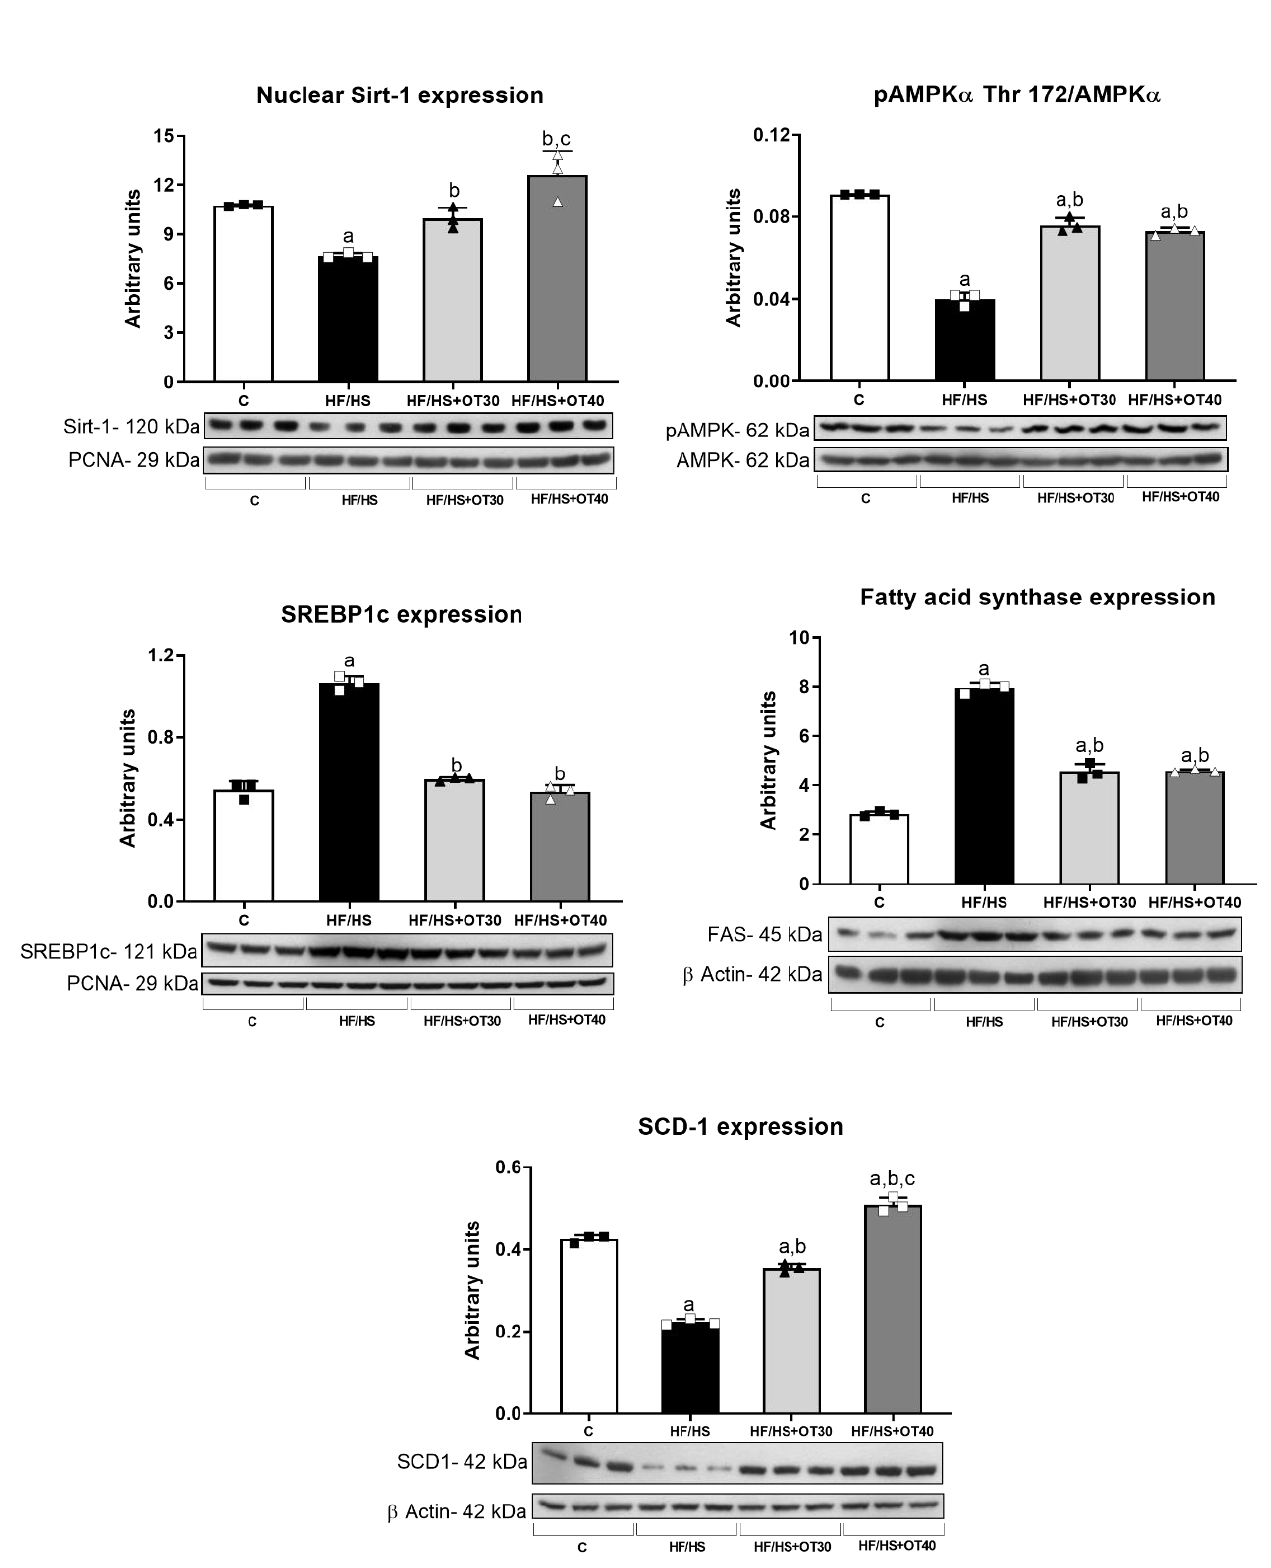
Figure 5. Lipogenesis studies. Renal expression of Sirt-1, stearoyl CoA desaturase 1 (SCD-1), AMPK α , phospho-AMPK α Thr 172, SREBP1c, and fatty acid synthase (FAS). For Western blotting, 3 randomly selected samples per group were analyzed. Results are presented as the mean ± SD and analyzed by one-way ANOVA. Post hoc analysis was performed using Bonferroni’s test. a: p < 0.05 vs. C; b: p < 0.05 vs. HF/HS; c: p < 0.05 vs. HF/HS + OT30.